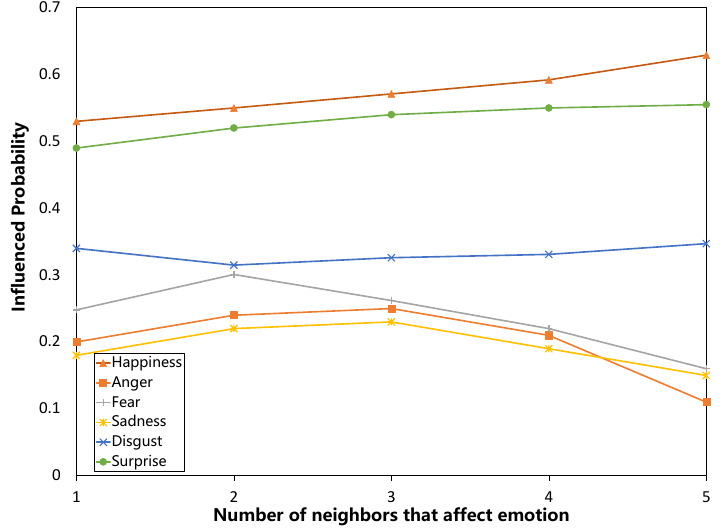
Figure 4. Correlation between neighbors’ emotions and user’s future